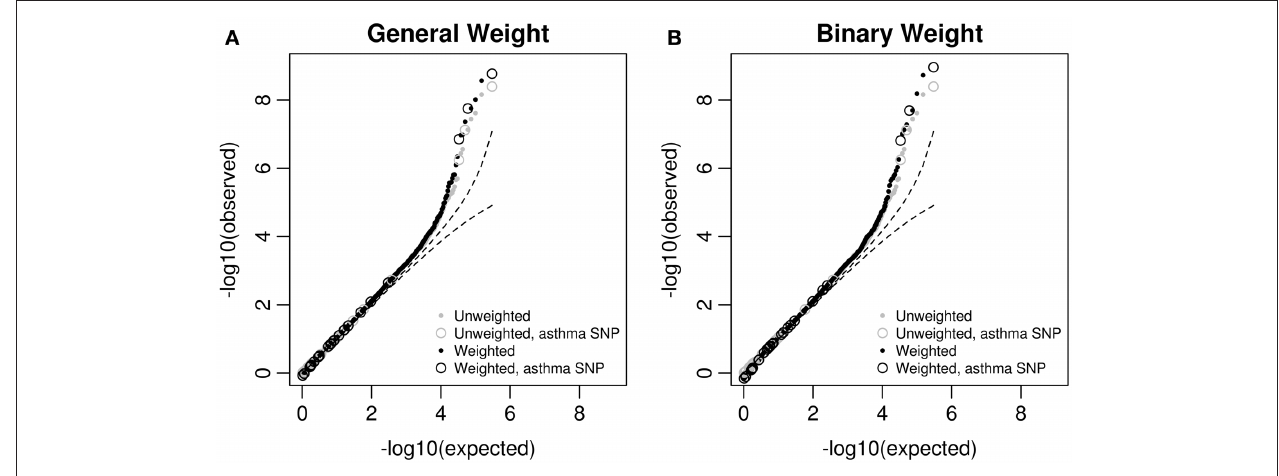
Table 1 | Additional significant SNPs or positive results identified by eQTL weighting methods after accounting for linkage disequilibrium in the MAGICS analysis.